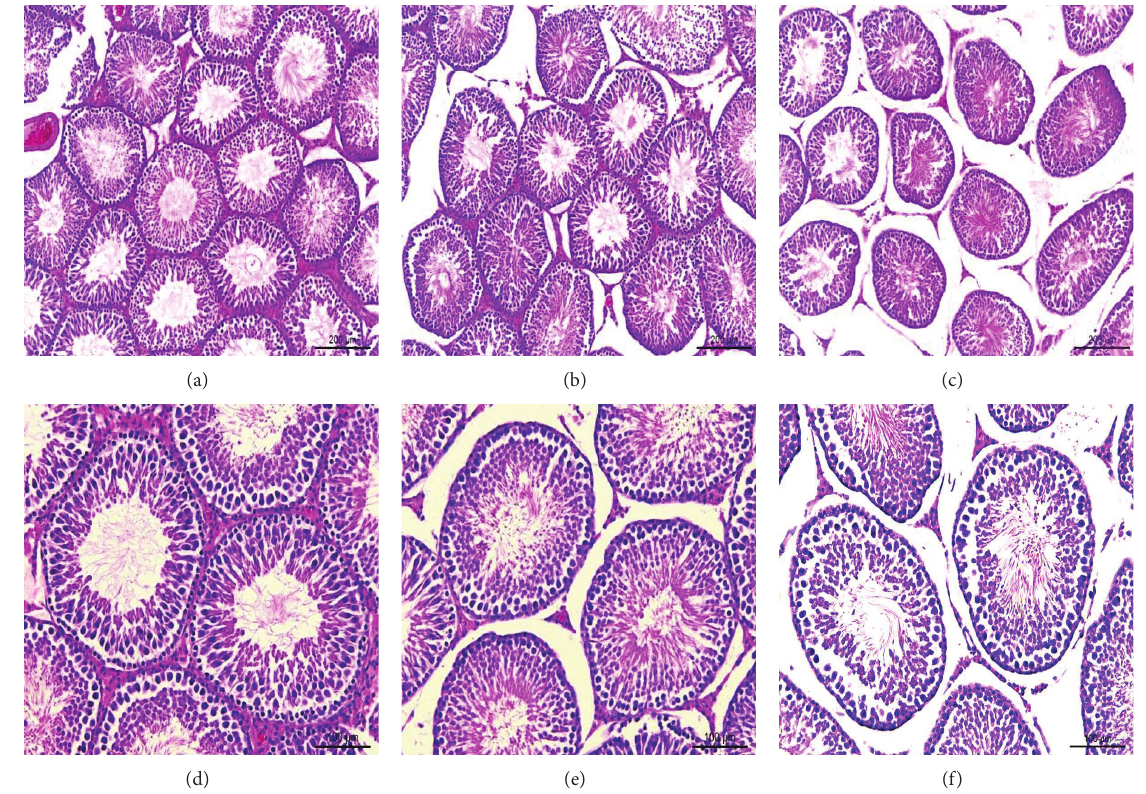
Figure 4: Representative sections of the testis from the control and caffeine-fed groups. The tissues were stained with hematoxylin and eosin. Sections from the control ((a), (d)), CF1 ((b), (e)), and CF2 ((c), (f)). CTRL, control; CF1, caffeine 120mg/kg/day; CF2, caffeine 180 mg/kg/day. Scale bars: (a) ∼ (c) = 200 𝜇 m; (d) ∼ (f) = 100 𝜇 m.